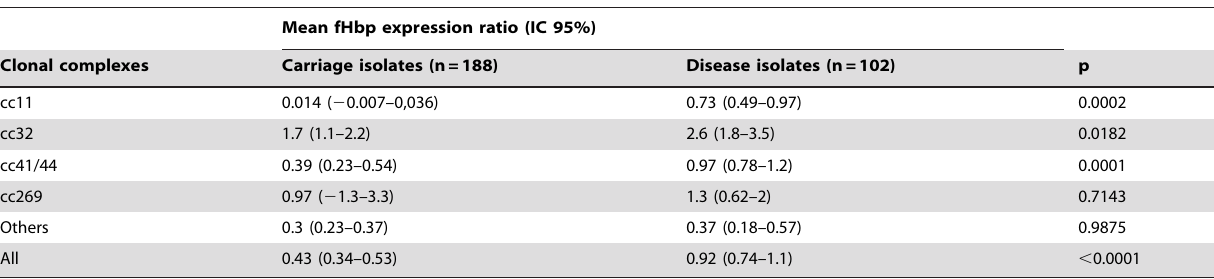
Table 3. Values of ratios of fHbp expression level among carriage and invasive